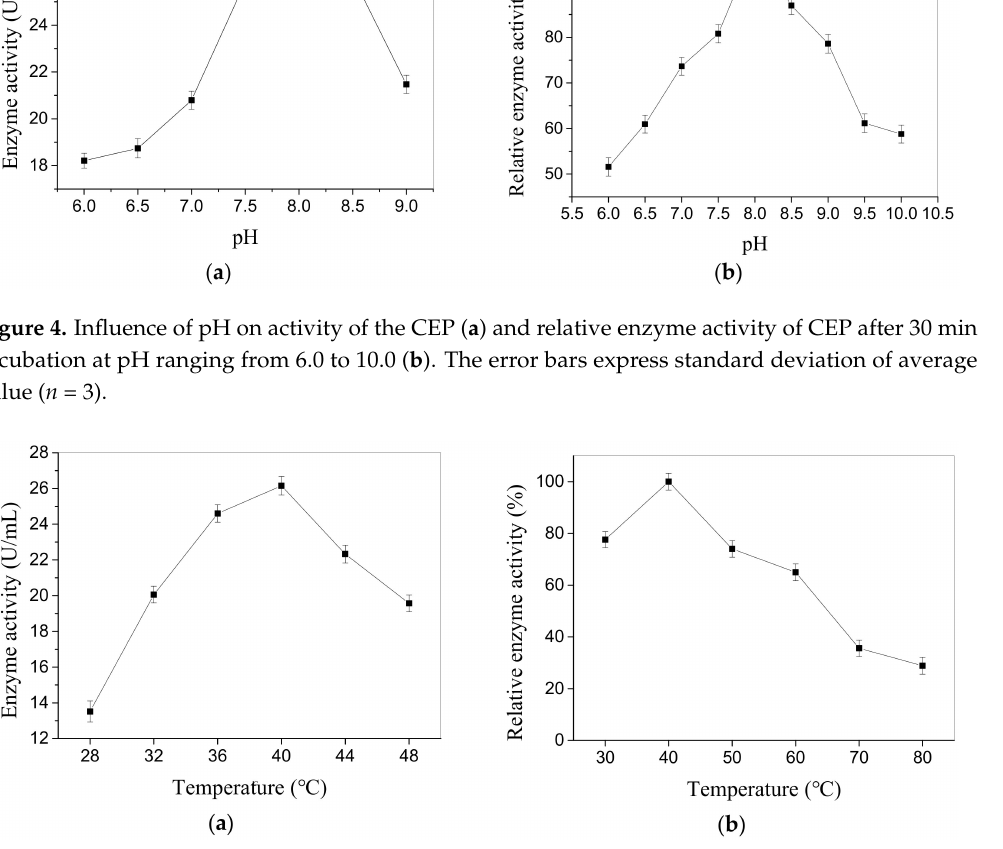
Figure 5. Influence of temperature on activity of the CEP ( a ) and relative enzyme activity of CEP after 30 min incubation at temperatures ranging from 30 to 80 ◦ C ( b ). The error bars express standard deviation of average value ( n =